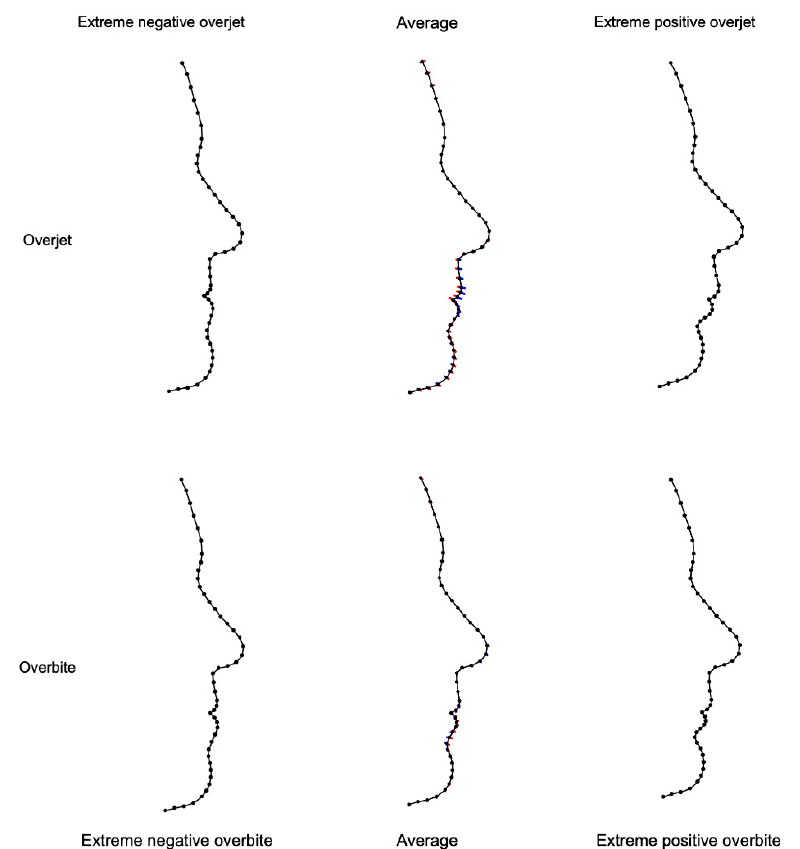
Figure 3. Profile morphings according to overjet (top row) and overbite (bottom row). The middle column depicts the average facial shape of the entire sample, as well as the amount and direction of variation at each profile landmark (blue: positive, red: negative), as explained by overjet (top row) and overbite (bottom row) values. On each row, the images left and right of the average present profile shapes of extreme overjet (top) and overbite (bottom) values.